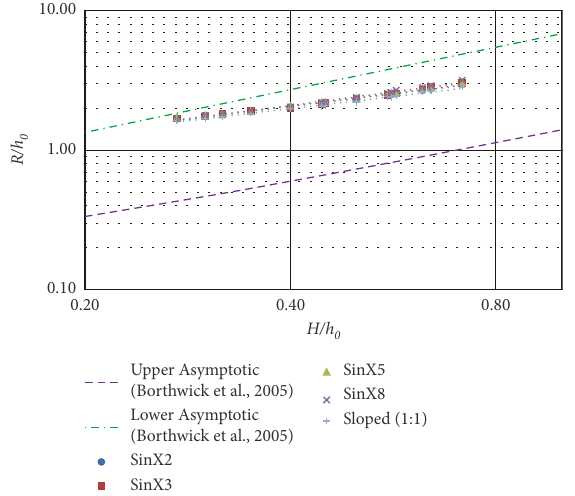
Figure 20: Comparison of normalized wave run-up versus nor- malized wave height for sinusoidal and sloped ones.